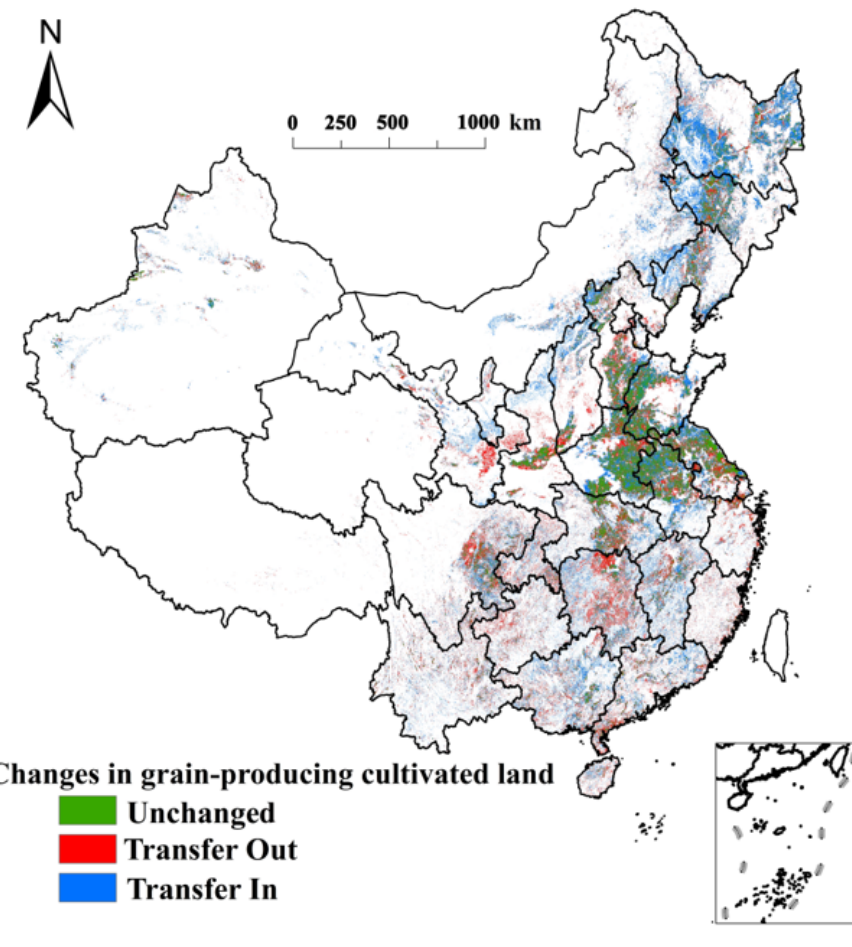
Figure 2. Grain-producing cultivated land (GPCL) changes from 2000 to 2018.